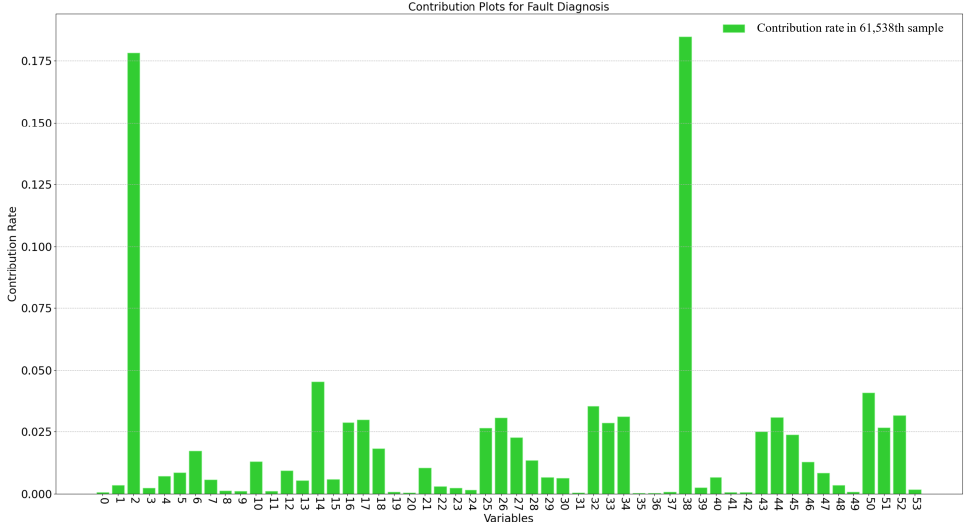
Figure 16. Contribution plots calculated in 61,538th sample.